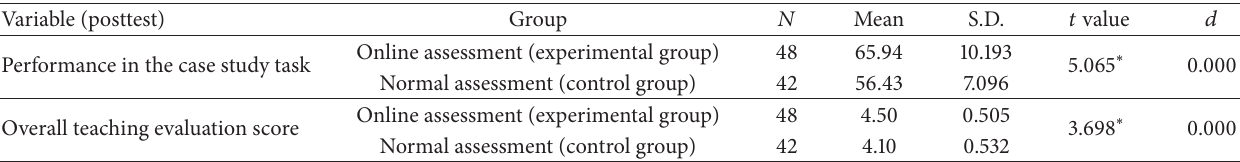
Table 6: 𝑡 -test results: differences between two cohorts of